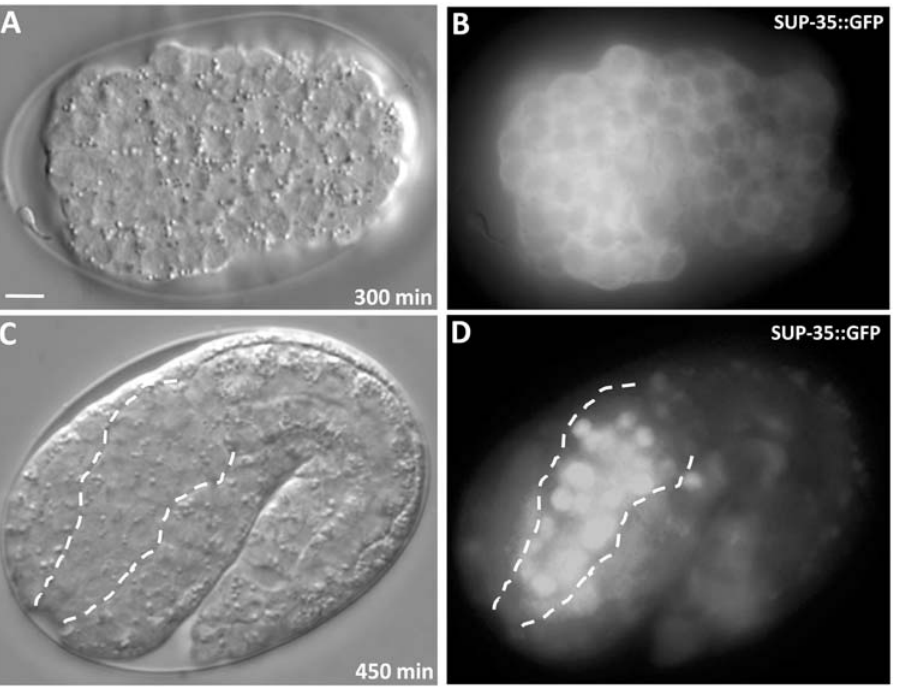
Figure 2. SUP-35::GFP expression. (A–D) DIC (A,C) and corresponding GFP (B,D) images of SUP-35::GFP ( fdEx57 ) expression in embryos. The SUP- 35::GFP reporter encodes a full-length functional fusion protein that is expressed under the control of the native sup-35 promoter. Prior to overt morphogenesis (A,B), SUP-35::GFP expression is predominantly cytoplasmic. After the initiation of body morphogenesis, SUP-35::GFP becomes enriched in nuclei (C,D). The developing primordial pharynx is outlined by dashed lines in C and D. The embryos depicted are homozygous for a mutation in sup-36(e2217) identical results were obtained using an independently generated array ( fdEx58 ). Identical results were also obtained using analogous arrays in the sup-37(e2215) background. Anterior is to the left. Scale bar in A, 10 m m for A–D.